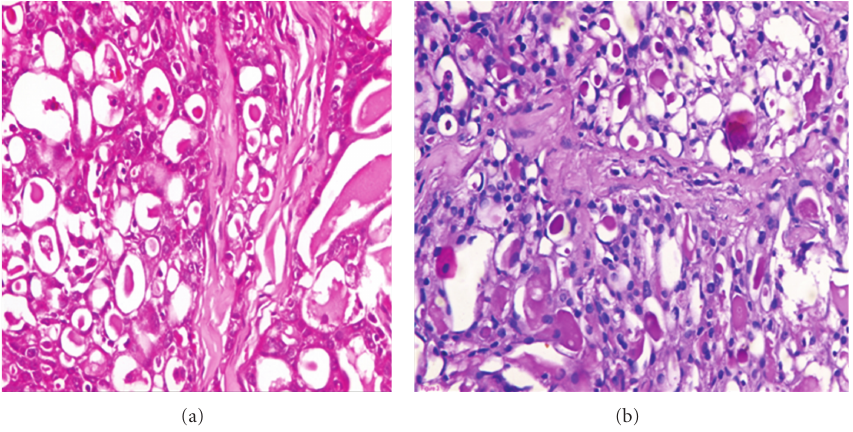
Figure 1: Secretory carcinoma shows microcystic pattern and intraluminal secretion, (a) (H&E) and (b) (PAS).